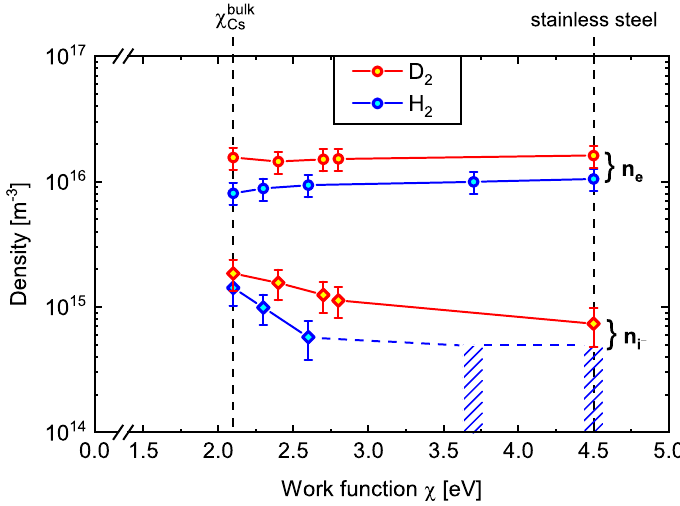
Figure 5. Comparison between deuterium (in red) and hydrogen (in blue) for the negative ion density and the electron density for different work